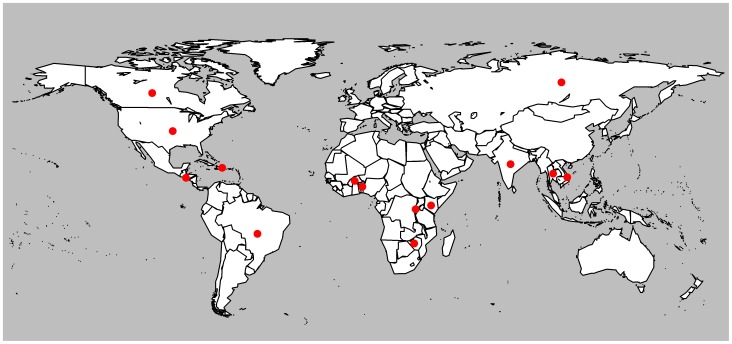
Map of Study Locations.Red dots highlight the countries where included studies were conducted.